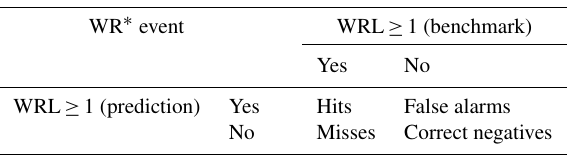
Table 4. Contingency table for legally binding water restriction (WR ∗